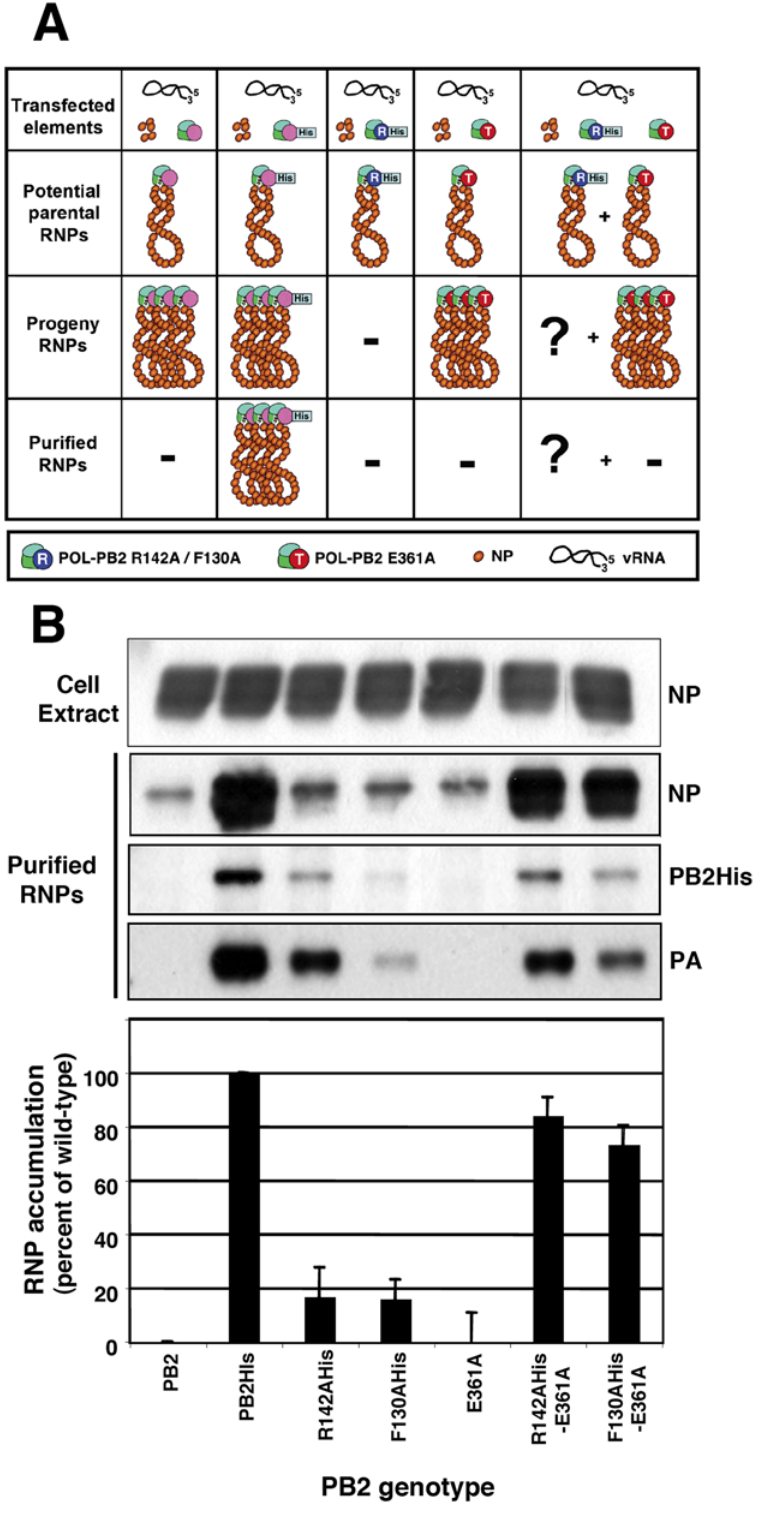
Figure 1. Intracistronic polymerase complementation during influenza virus RNA replication. (A) Cultures of HEK293T cells were transfected with plasmids expressing a virus-like replicon of 248 nt, the NP and various combinations of the polymerase subunits as indicated in the diagram. The potential RNPs that could be generated are also depicted in the diagram, as well as the expected progeny RNPs, depending on the replication phenotype of the polymerase mutants used. (B) The progeny RNPs were purified from total cell extracts over Ni 2 + -NTA-agarose resin and analysed by Western-blot with anti-NP antibodies. The top panel presents the accumulation of NP in the total cell extract whereas the bottom panel shows the NP accumulation of purified RNPs. The integrity of the purified RNPs is verified by Western-blot using anti-PB2 and anti-PA antibodies. In the bottom graph the average NP accumulation and standard deviation of three independent complementation experiments are presented as percent of maximal value.